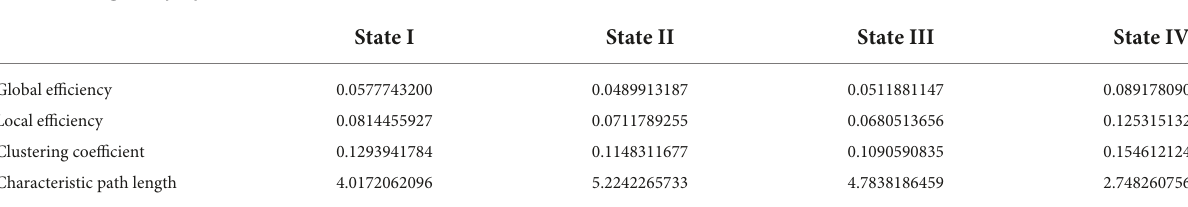
TABLE 2 The global properties for each